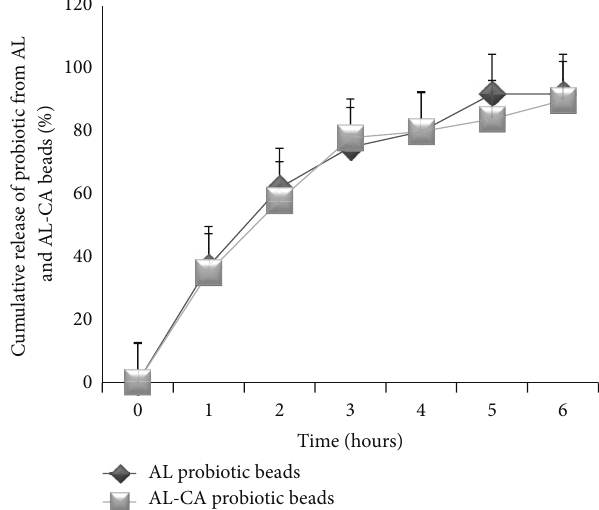
Figure 2: The in vitro release study for AL and AL-CA beads up till 6 hours. No significant difference was found for the two types of